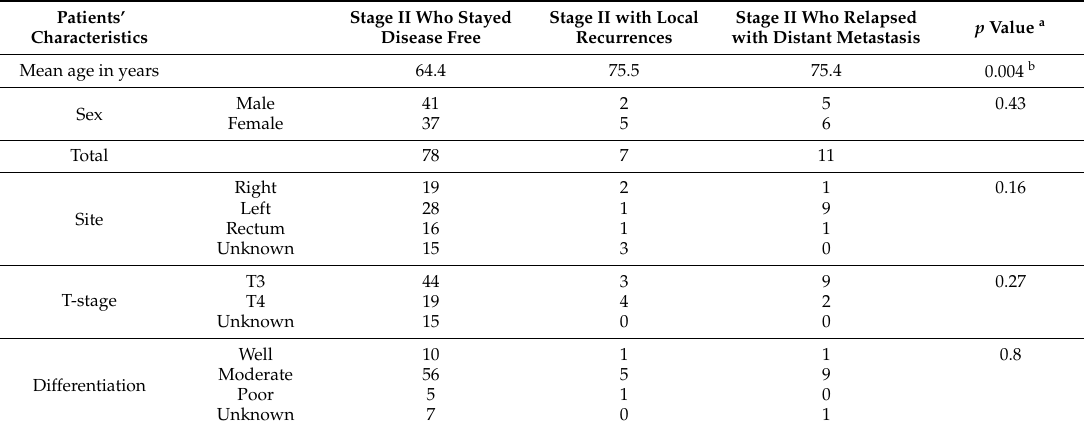
Table 1. Clinicopathological characteristics of stage II CRC